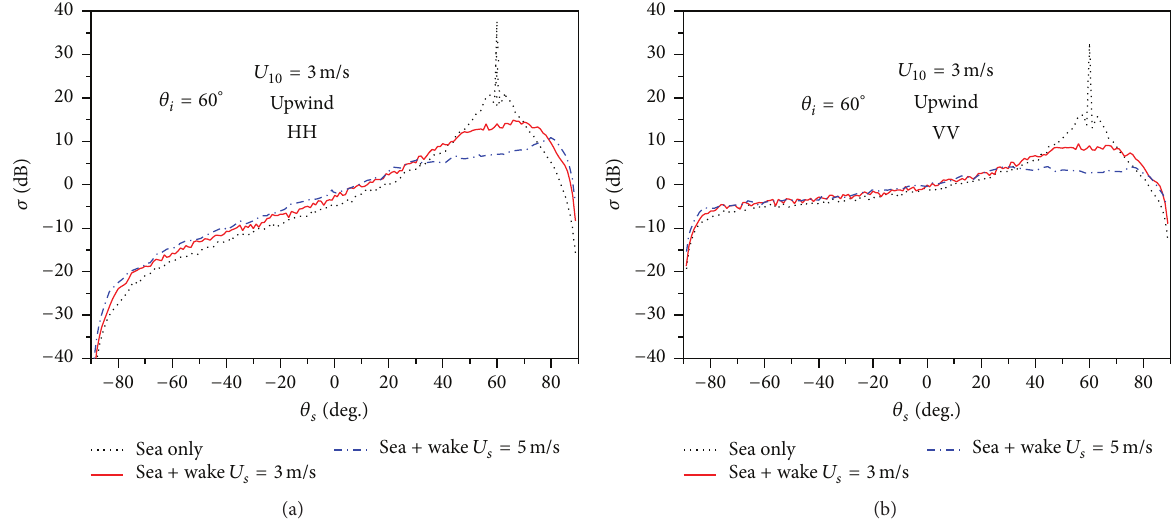
Figure 10: Similar to Figure 9, but with incident angle 𝜃 𝑖 = 60 ∘ . (a) HH-polarization and (b)